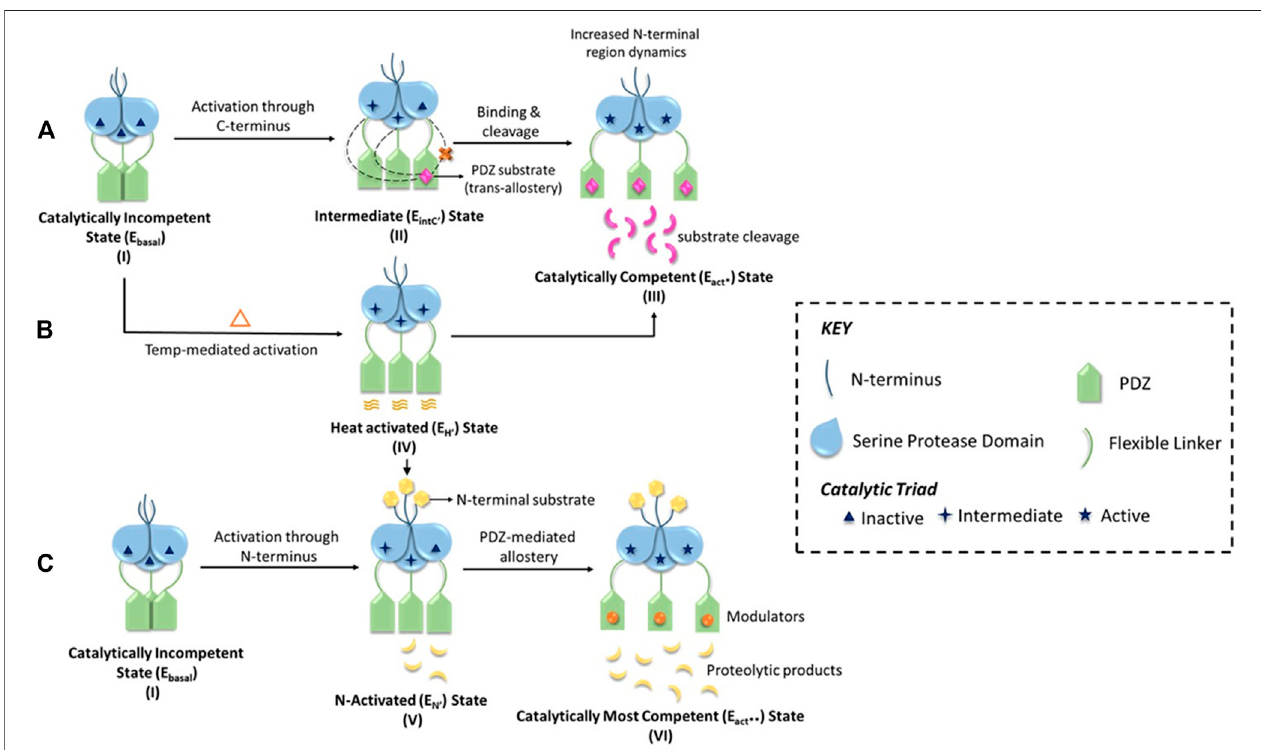
FIGURE 2 | AschematicrepresentationofthemultimodalactivationmechanismofHtrA2. (A) HtrA2inthesubstrate-unboundstate (I) exhibitsnegligibleactivity( E basal state ) since the active site it embedded within the trimeric ensemble, and encircled by the regulatory PDZ domains. In the second step (II) , initial binding of one substrate molecule at the distal PDZ domain (e.g., DUSP-9) reorients different domains and loops of HtrA2 making it conducive for catalysis ( E IntC ’’ state or C-terminal mediated intermediatestate ).Instep (II) ,thedottedlinesfromPDZtowardadjacentSPDdomainshighlightintermolecularcrosstalk,whichisshowntobeabsentwithinthesame moleculethroughared ‘ x ’ sign.Therefore,thisstepunderscorestheimportanceof trans -mediatedallosterywherebindingofsubstratemoleculetoaPDZactivatesprotease domainsoftheadjacentsubunitsofthetrimer. Further binding ofsubstratestoallthePDZ domains (III) ,activatestheproteaseviaconformationalalterations throughoutthe proteinmoleculeleadingtoanoptimallyactivestate( E act* state ). (B) Ontheotherhand,withincreaseintemperature,thePDZsexperienceenhancedthermalmotionleadingto an open active-site conformation ( E H ’ state or heat-mediated active state ) asshown in (IV) . This conformation might be important in some scenarios for preparing the basal proteasetoreadilybindsubstratesofdistinctcellularpathwayseither/bothattheN-terminalor/andthePDZdomains(shownbyarrows). (C) RepresentsN-terminalmediated allostericactivationofHtrA2,wherethebasalstate (I) bindstotheN-terminalbindingpartners(suchasIAPs)ofHtrA2thatleadstofavorableconformationalalterationsinthe distal protease and PDZ domains leading to an active state ( E N ’ state or N-terminal mediated activated state ) as shown in step (V) . This conformational state can further be modulated through temperature and/orPDZ domains leading tothe mostactiveprotease( E act** state ) asshown in (VI) . Thisunique model shows intricate crosstalk among distinct activation networks that might or might not be mutually exclusive depending upon speci fi c cellular